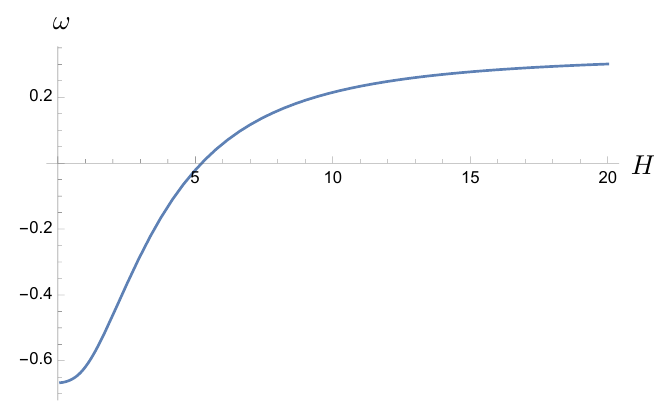
Figure 2 . The dependence ω ( H ) at fixed value of the mass m = 2